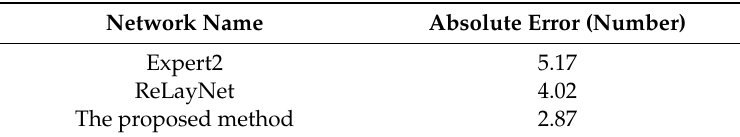
Table 5. The average absolute error of the number of edema regions with expert 1 annotations as the ground truth.